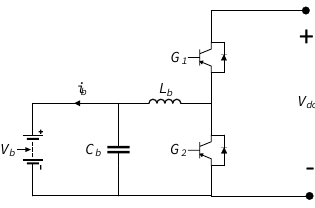
Figure 4. Bi-directional DC-DC converter circuit topology.